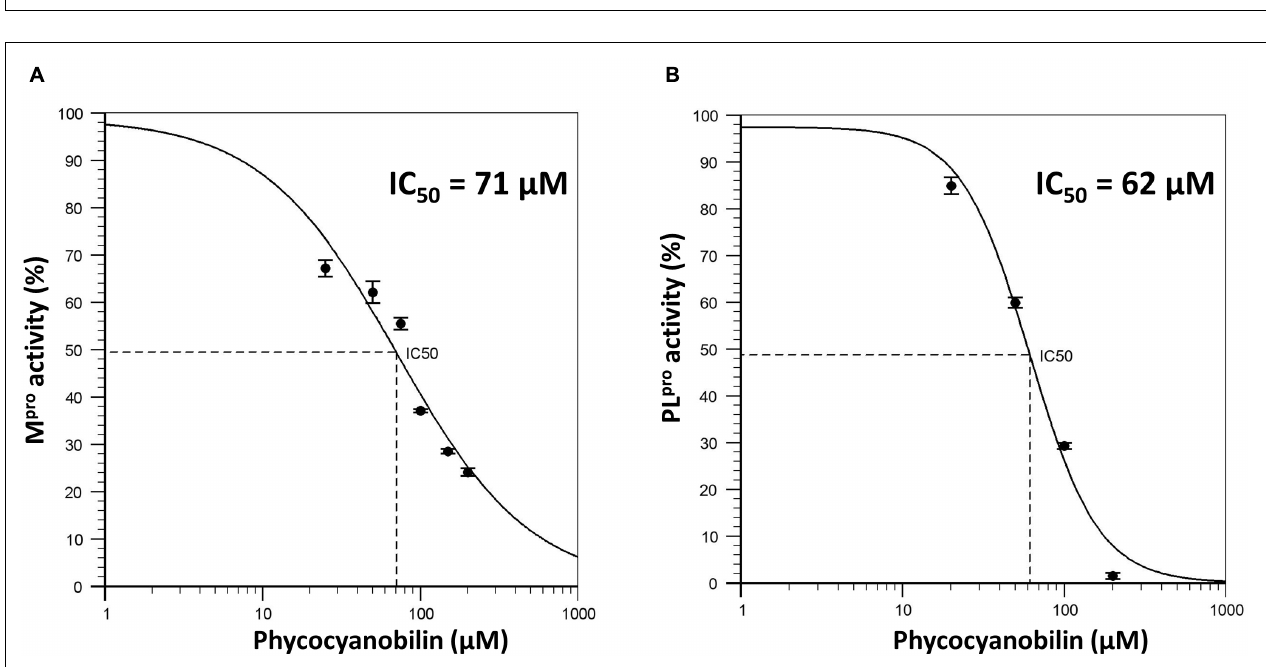
FIGURE 2 | Initial screening of phytochemicals (selected based on docking score and our availability) by in vitro enzymatic assays; (A) Mpro assay; (B) PLpro assay; P control, positive control; I control, inhibitor control; PC, phycocyanobilin; QC, quercetin; GS, genistein; CD, cyaniding; RF, riboflavin.